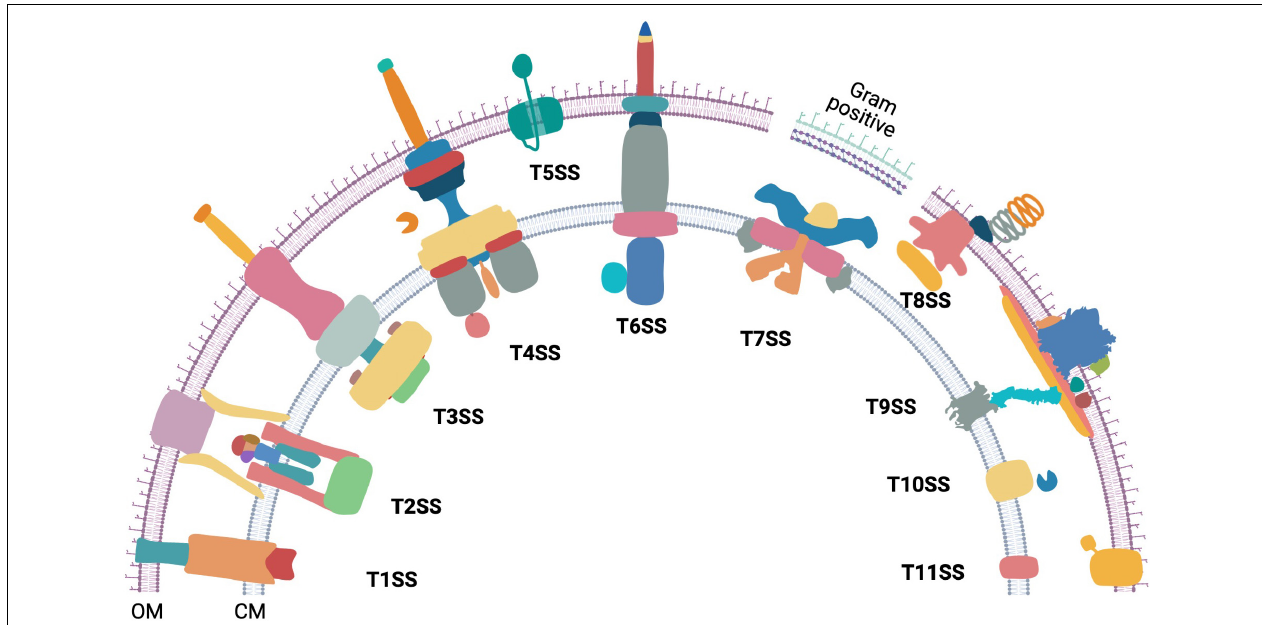
FIGURE 1 | The diversity of bacterial protein secretion systems. Graphical representation of the currently known bacterial protein secretion systems ranging from Type 1 to Type 11 and their localization in the outer (OM) and cytoplasmic membrane (CM). Except T7SS (Gram positive), all the above shown secretion systems are found in Gram negative bacteria. Occurrence of T7SS mediated protein secretion is found within some Gram positive members of the phylum Actinobacteria that have an outer lipid